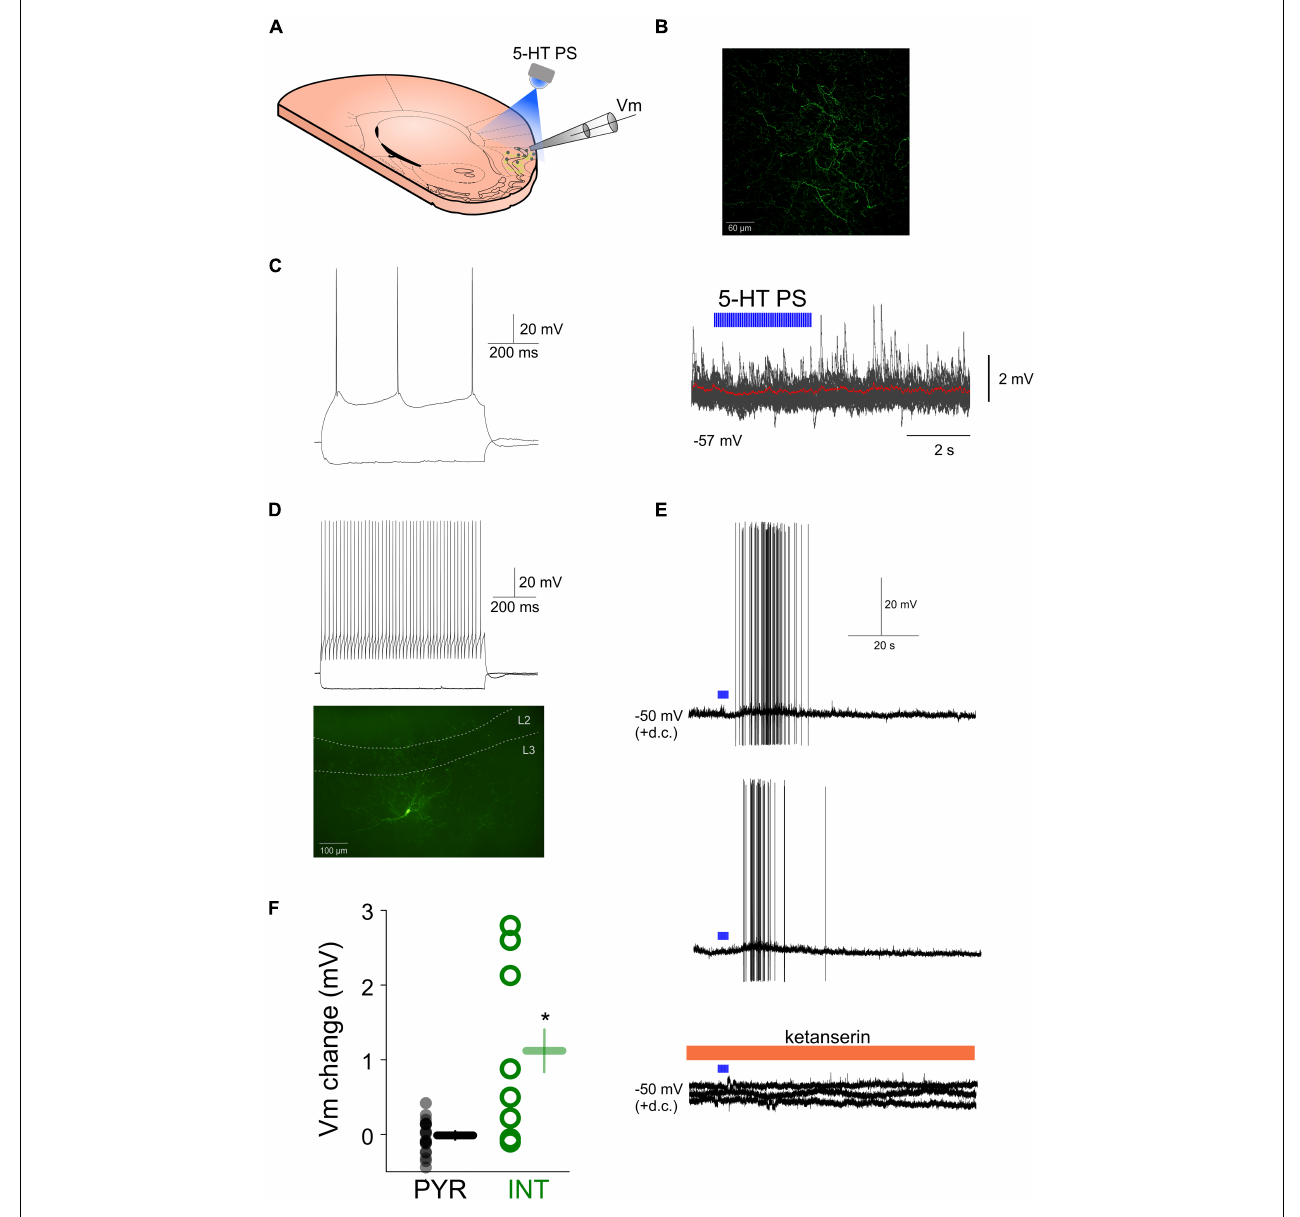
FIGURE 2 | Effects of endogenously released 5-HT on aPC principal neurons and interneurons. (A) Schematic of the experimental design. (B) Confocal image of ChR2-YFP expressing fibers in the aPC of a SERT-cre mouse previously injected with AAV-DIO-ChR2-eYFP in the DRN. (C) Membrane potential responses of an aPC pyramidal neuron to hyperpolarizing and depolarizing current steps (left) and lack of effect of local photostimulation (10 ms pulses, 20 Hz, 5 mW, 3 s) of DRN 5-HT axons in the aPC on the membrane potential (left, 20 sweeps overlayed, red trace: average). (D) Membrane responses to hyperpolarizing and depolarizing current steps (top) and morphology (bottom) of an aPC fast spiking interneuron. (E) Effect of local photostimulation (10 ms pulses, 5 mW, 20 Hz, 3 s) of DRN 5-HT axons in the aPC on the membrane potential of the neuron shown in (D) (two consecutive sweeps). The depolarizing effect is blocked by ketanserin (bottom, three consecutive sweeps). (F) Effects of 5-HT photostimulation on all recorded aPC pyramidal neurons (PYR, gray circles, n = 20) and interneurons (INT, green circles, n = 8). * p <